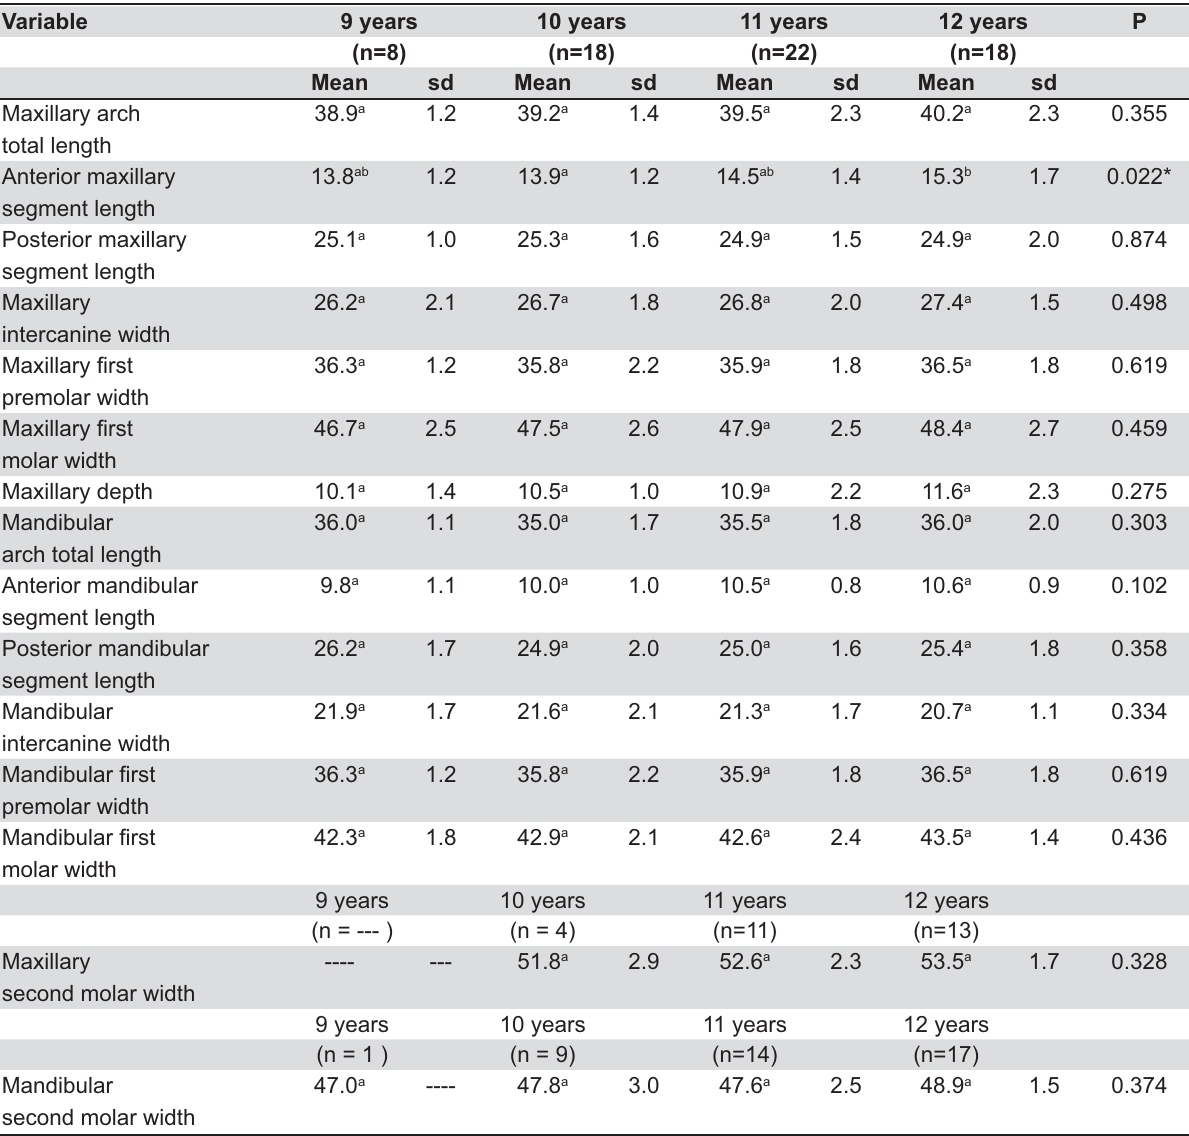
Table 1- Means and standard deviations of age and results of ANOVA